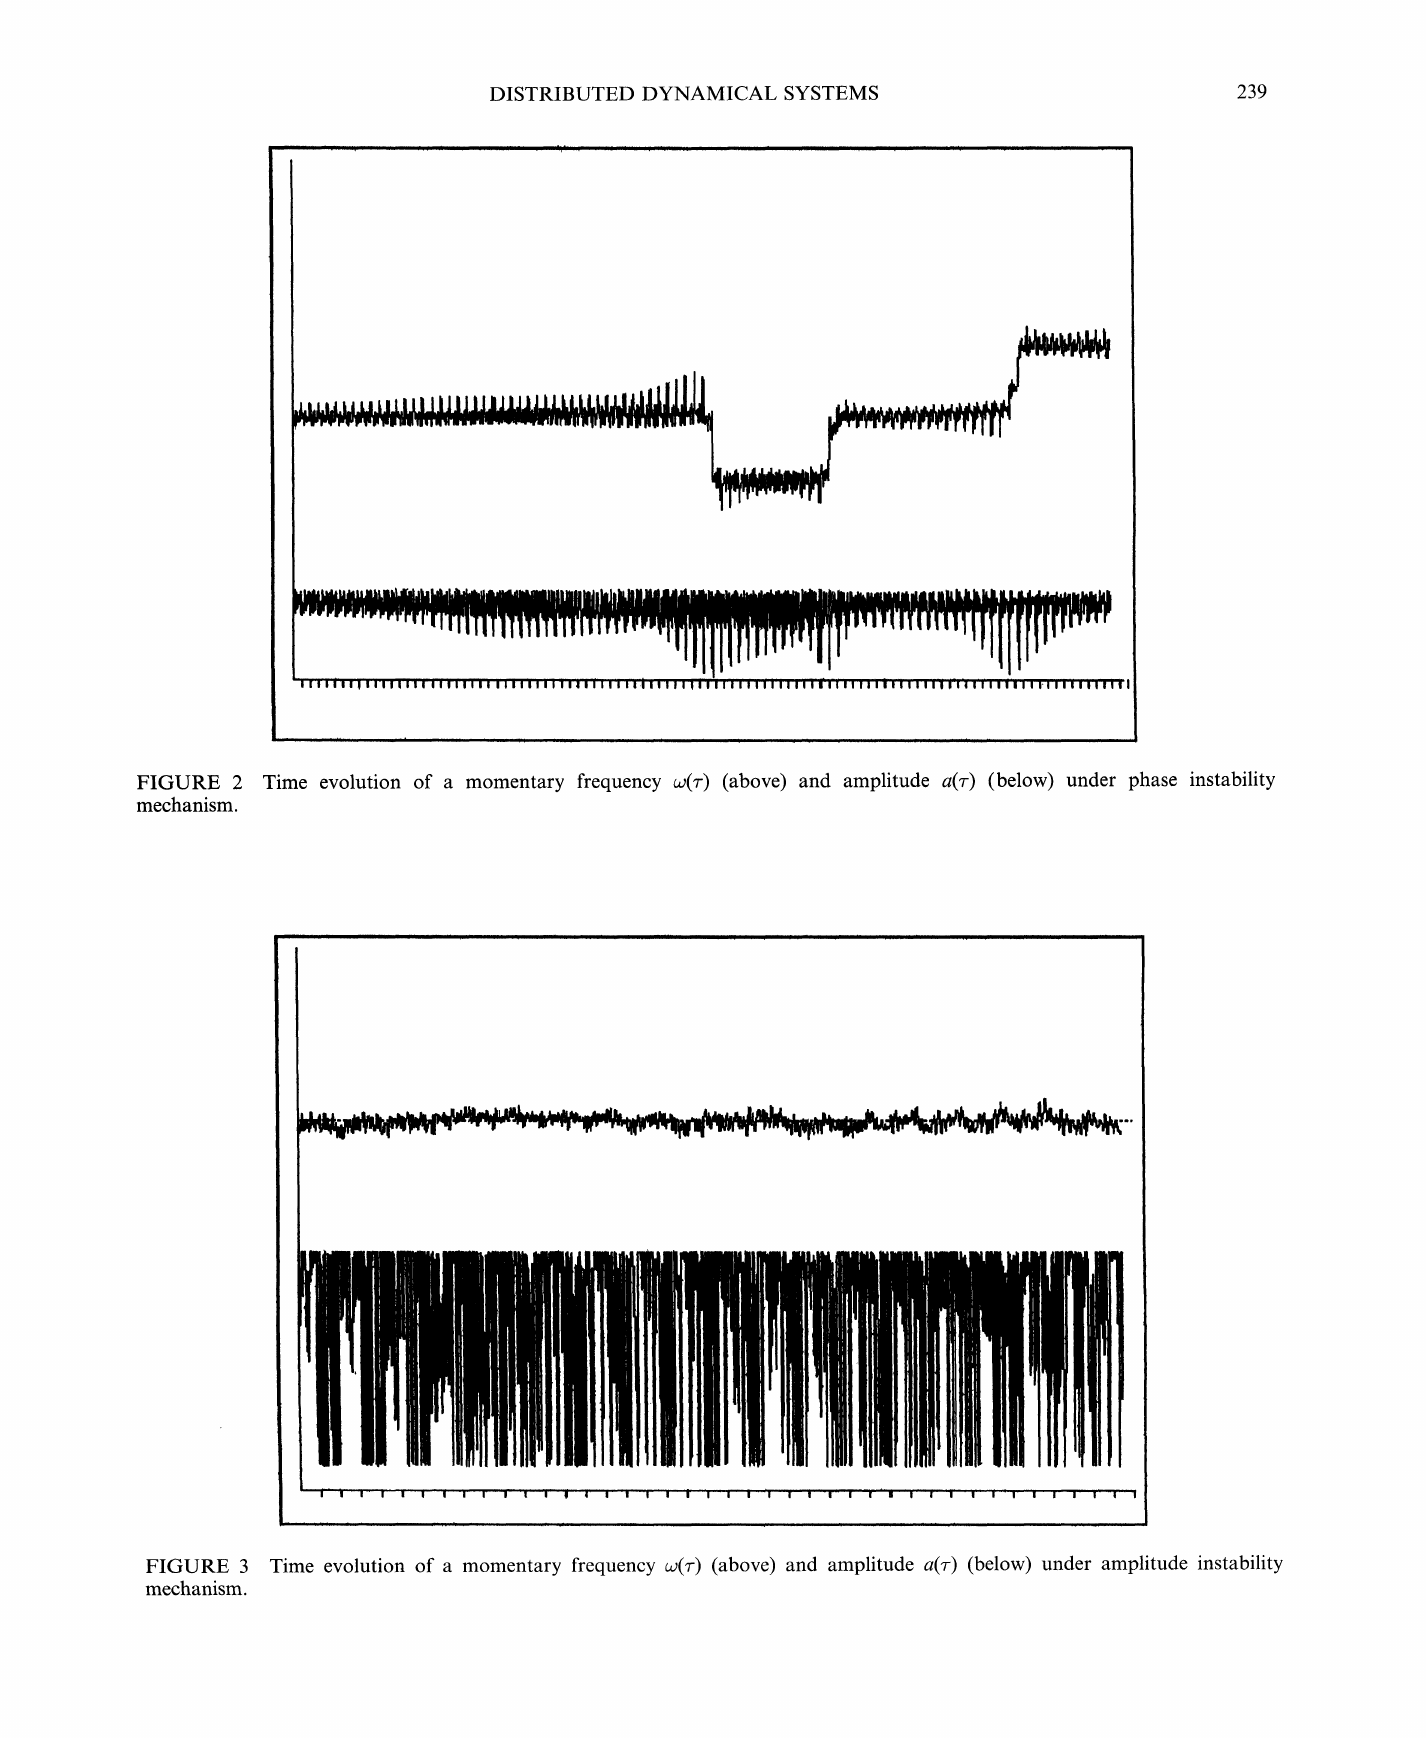
FIGURE 3 Time evolution of a momentary frequency (-) (above) and amplitude a(-) (below) under amplitude instability